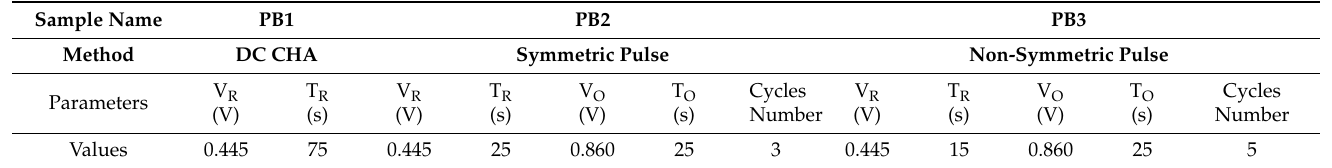
Table 1. PB thin film electrodeposition parameters, namely: reduction voltage (V R ), oxidation voltage (V O ), reduction time (T R ), oxidation time (T O ), and number of cycles for pulse